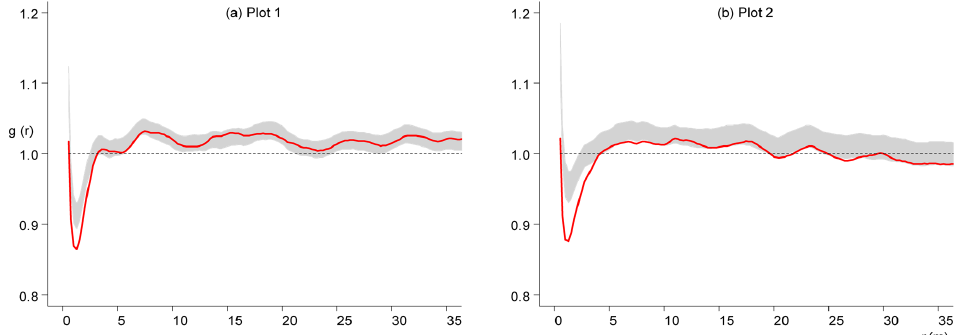
Figure 6. Comparisons between post ‐ mortality patterns and pre ‐ mortality patterns using random labelling as the null model in plots 1 ( a ) and 2 ( b ) . Red curves denote the observed pair ‐ correlation function of live trees. The envelopes ( grey areas ) denote the range of pair ‐ correlation function of a random mortality process, and were constructed from the 2 . 5% and 97 . 5% quantiles of 1000 Monte Carlo simulations . It indicates a more regular post ‐ mortality pattern of surviving trees if the observed curve lies below the simulation envelopes.